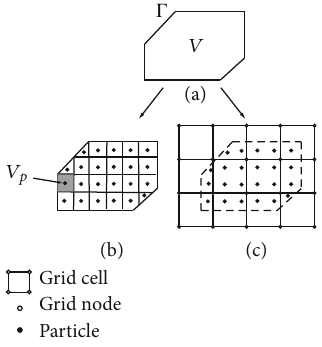
Figure 1: Material point method [8]: (a) material domain, (b) material represented by material points, and (c) discretization by material